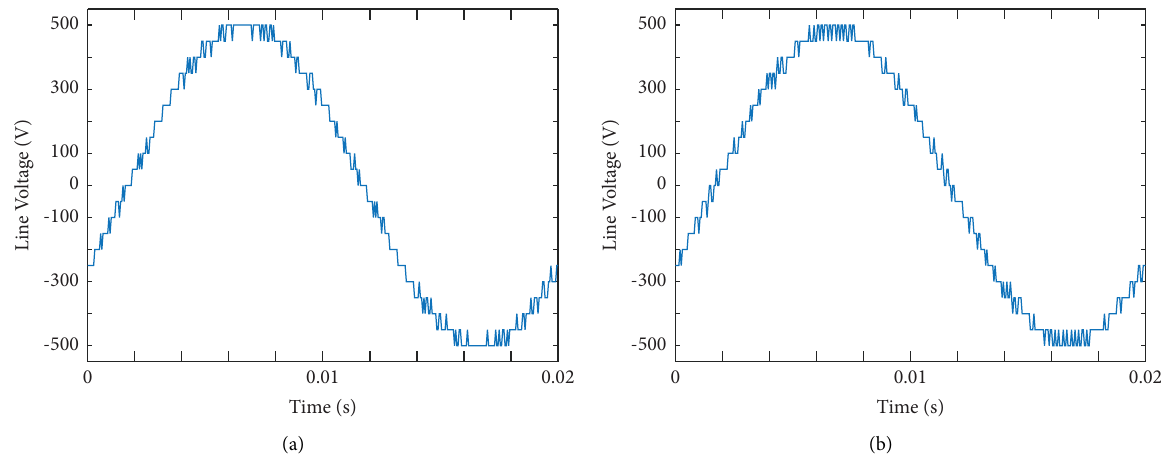
Figure 15: Microscopic view of line voltage at M � 1.0. (a) SVPWM-I. (b) SVPWM-II.